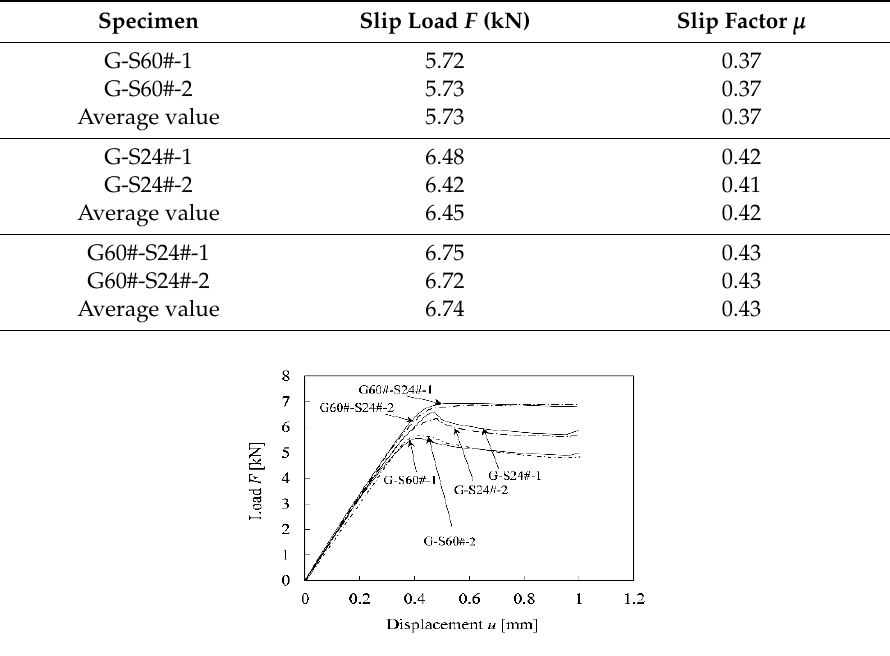
( a ) ( b ) Figure 9. Plate surfaces of G60#-S24# connection after shear test. ( a ) GFRP connecting plate surface after shear test; ( b ) stainless-steel cover plate surface after shear test. The slip factor of the G60#-S24# connection was the highest and the slip factor of the G-S60# connection was the lowest among the three connection types. The difference between the slip factors of three connections was minimal. Hashimoto et al. [5] tested the GFRP slip-critical connection with stainless-steel cover plates. In their experiments, the surfaces of stainless-steel cover plates were treated by grit-blasting. They found that the slip factor was 0.449. This value is close to the results from our tests, as listed in Table 8. Feo et al. [3] found that the slip factor value of the GFRP slip-critical connection with structural-steel cover plates was around 0.37, which is again similar to the results of our tests. It is clear that increasing the roughness of the faying surface using a grit-blasting treatment is a valid way to increase the slip load of GFRP slip-critical connections. The slip factor of the G60#-S24# slip-critical connection was slightly higher than that of the G-S24# slip-critical connection, indicating that grit-blasting treatment for GFRP plates was not greatly efficient or economic when stainless-steel plates were already blast treated. The grit-blasting treatment may damage the surface of the GFRP plates, therefore we do not propose any grit-blasting treatment for the GFRP plates. 3.3. The Effects of Prevailing Torque Based on the phenomenon and analysis above, the G-S24# connection was proven to be the optimal configuration with both efficient shear resistance and economy. As a result, the G-S24# connection only was selected to examine the influence of the prevailing torque on the slip factor of slip-critical connections. The prevailing torques used in the tests were 5 N·m, 6 N·m, 7 N·m, 8 N·m, 9 N·m, and 10 N·m. Each set of tests was performed with two identical specimens. The slip load and slip factor are listed in Table 9 and the load–displacement curves are shown in Figure 10. The load– displacement curves of the G-S24# connection with different prevailing torques in Figure 10 can be described by the (a) type curve from Figure 3. These curves are similar to the load–displacement curve of the G-S24# connection from Figure 7. Table 9. The slip load and factor values of tested connections with different prevailing torques.